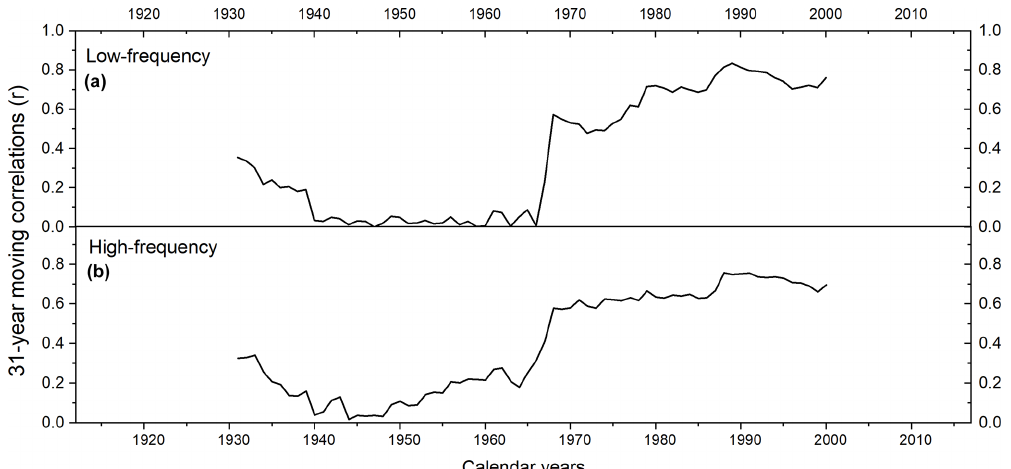
Figure 7. 31-year moving correlations between (a) low- and (b) high-frequency gridded instrumental and modelled summer